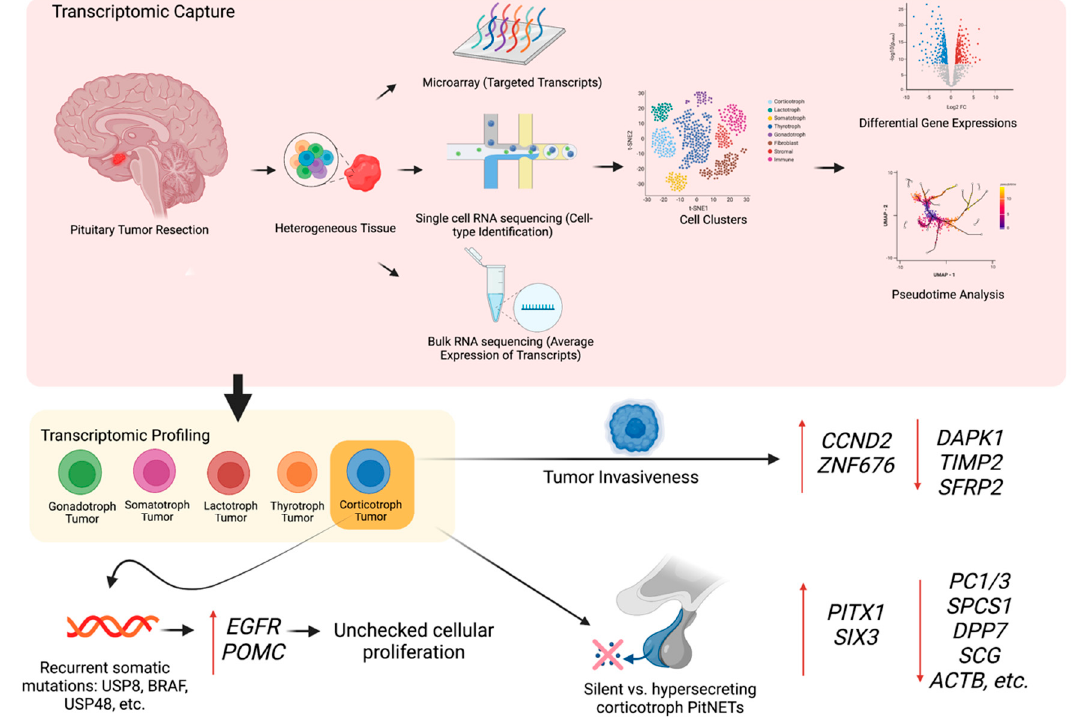
Figure 2. Transcriptomic profiling of pituitary neuroendocrine tumors. (TOP) A transcriptome captures a snapshot in time of diverse transcripts present in a pituitary tumor cell. Microarrays capture a set of predetermined sequences whereas single-cell RNA sequencing and bulk RNA sequencing capture all transcripts using high-throughput sequencing. In contrast to bulk RNA sequencing, single-cell RNA sequencing can identify and analyze cell subpopulations. (BOTTOM) Transcriptomic analysis reveals differentially expressed genes that drive various tumor behaviors, such as hormone hypersecretion and tumor invasiveness. Transcriptomic changes in a corticotroph tumor cell are highlighted in this diagram.